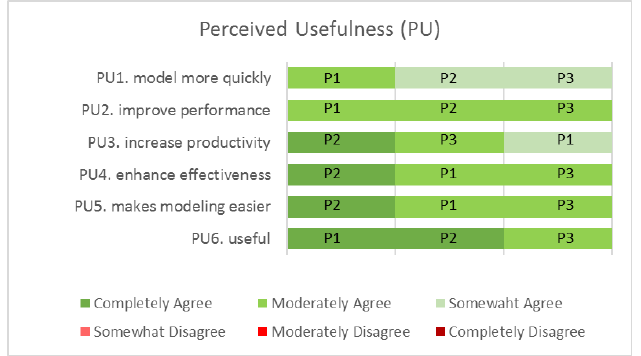
Fig 3. Perceived usefulness from the point of view of the participants.